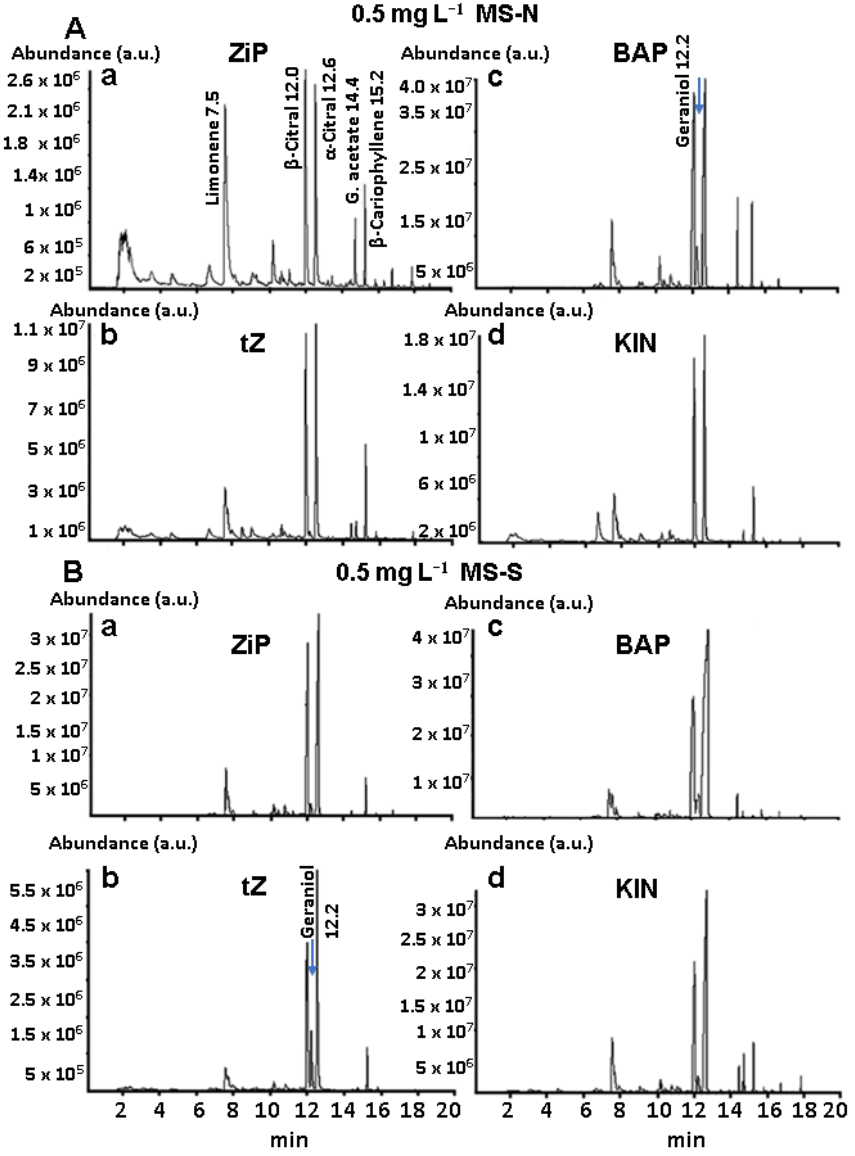
Figure 3. Terpenoid profile of essential oils from leaf samples of established plants in pots. Plants came from shoots grown on MS-N and MS-S media ( A , B ) with 0.5 mg L − 1 of the different CKs ( a – d ). Terpenoid names and retention times are shown . The blue arrow indicates the presence of geraniol.